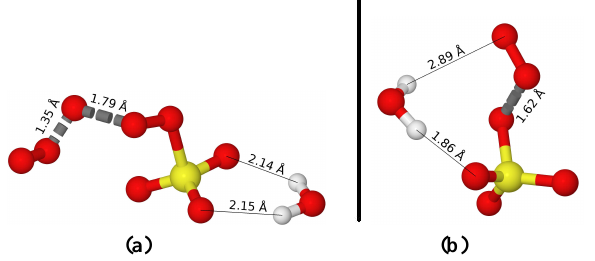
W to 3 W . The active 4